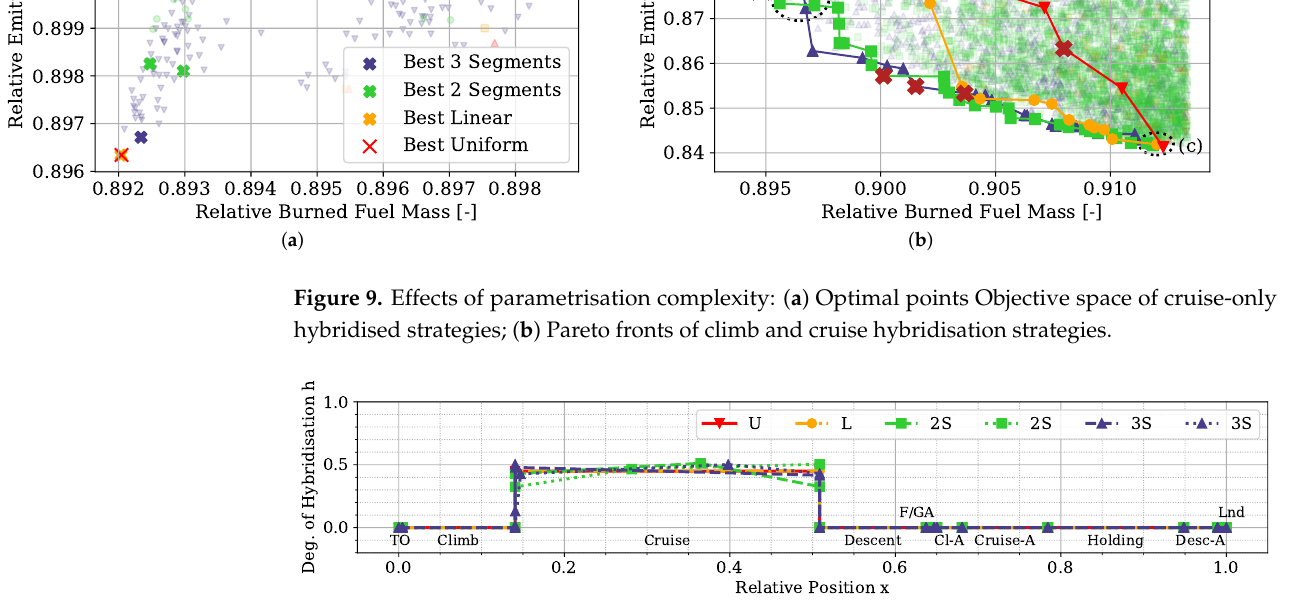
Figure 10. Hybridisation strategies of the optimal points of Figure